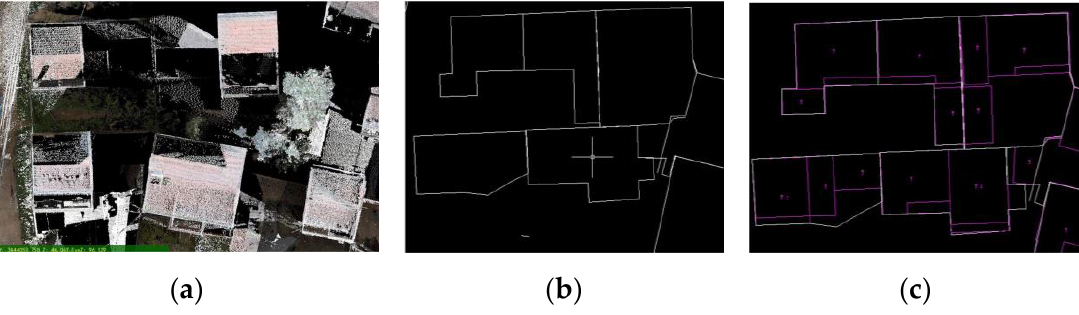
Figure 9. ( a ) A close-up view of fused points; ( b ) extracted building contours (white); and ( c ) an overlay of the extracted and vector mapping reference (purple).